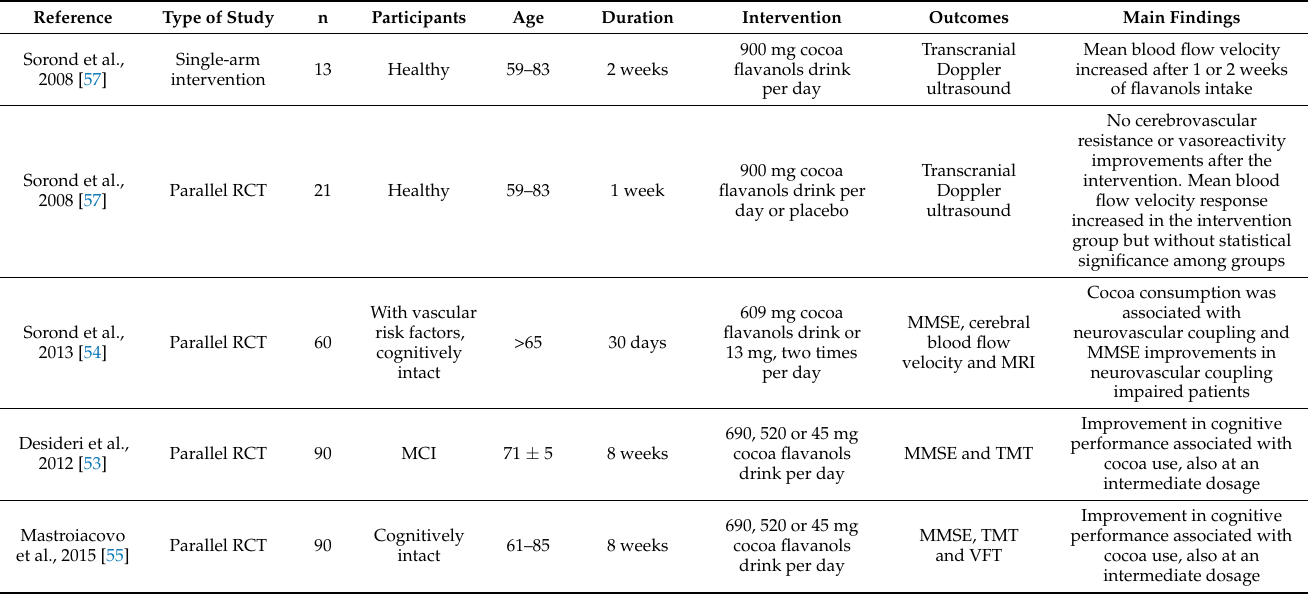
Table 2. Main characteristics of selected interventional